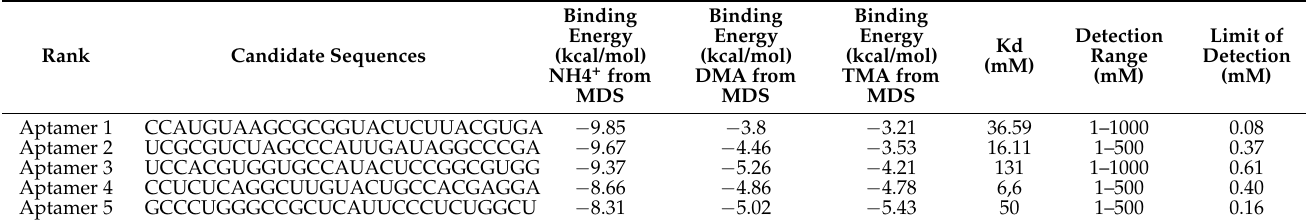
Table 1. Top five candidates selected by the